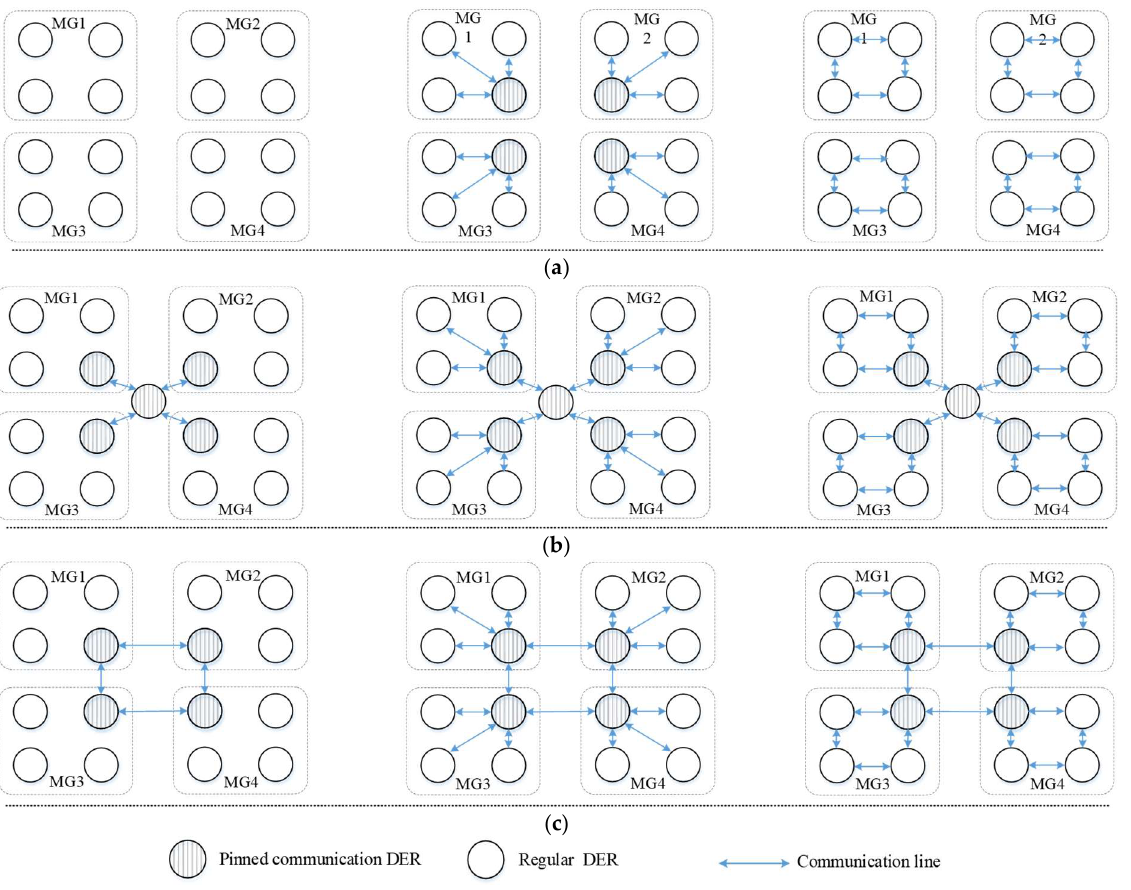
Figure 1. Control structure of NMGs. ( a ) Fully decentralized control among MGs, ( b ) Centralized control among MGs, ( c ) Distributed control among MGs.